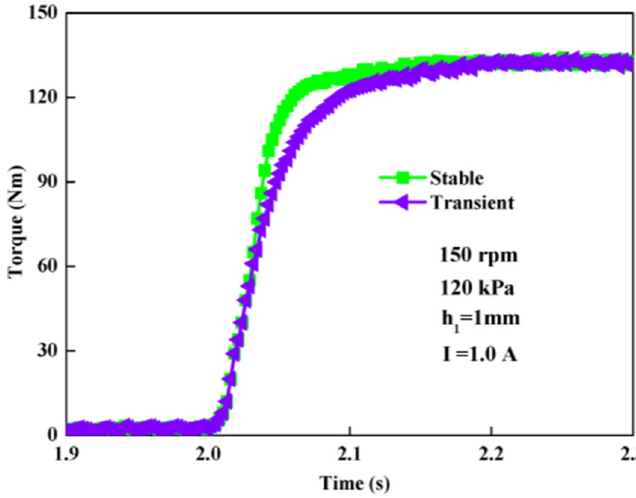
Figure 8. Comparison between transient and stable torque processes.